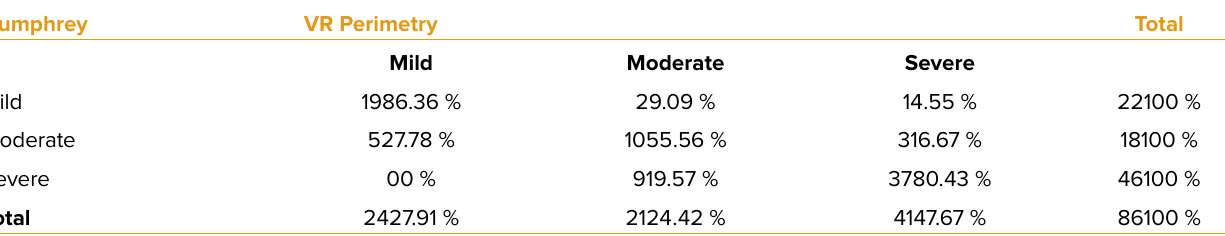
Table 3. Table showing the classification of severity of glaucoma according to Palm Scan VF2000 ® Virtual Reality Visual Field Analyzer and Humphrey Field Analyzer in 86 glaucomatous